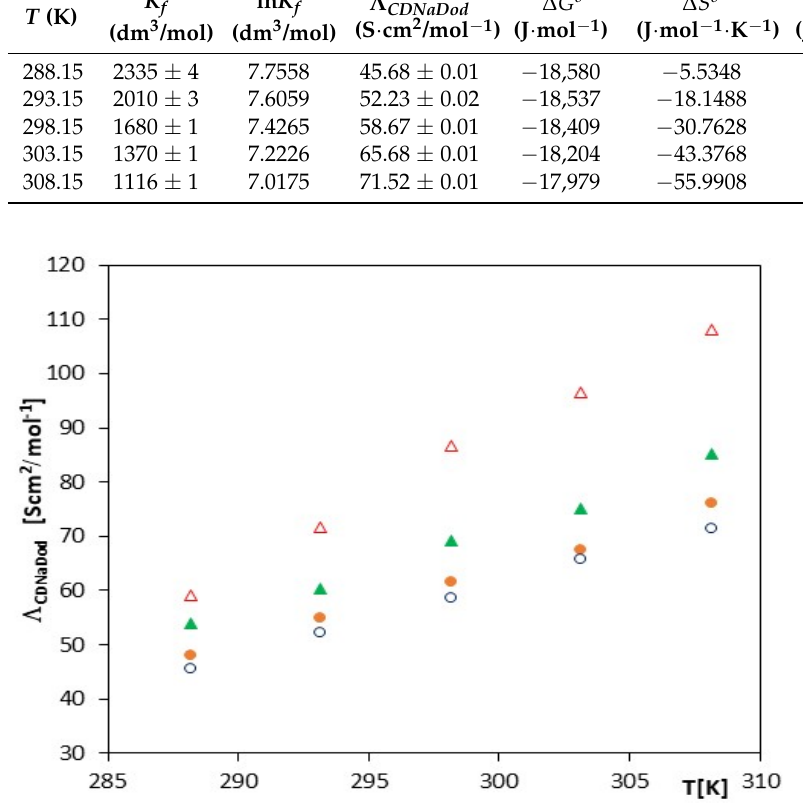
Figure 1. The plots of the dependence of the theoretical conductivity Λ CDNaDod (S ∙ cm 2 /mol − 1 ) in the function T (K) for α -cyclodextrin with all studied salts: ∆ - trans -cinnamic acid; ▲ - trans - p -coumaric acid; ● - trans -caffeic acid; and ○ - trans -ferulic acid.